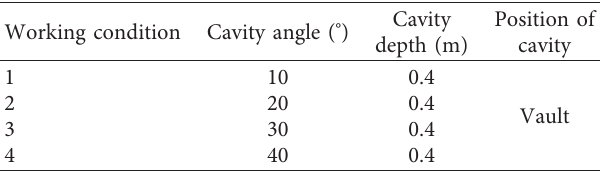
Figure 10: Comparison of bending moment values of the cavity behind the vault (unit: kN · m). Table 4: Numerical simulation conditions of different angle